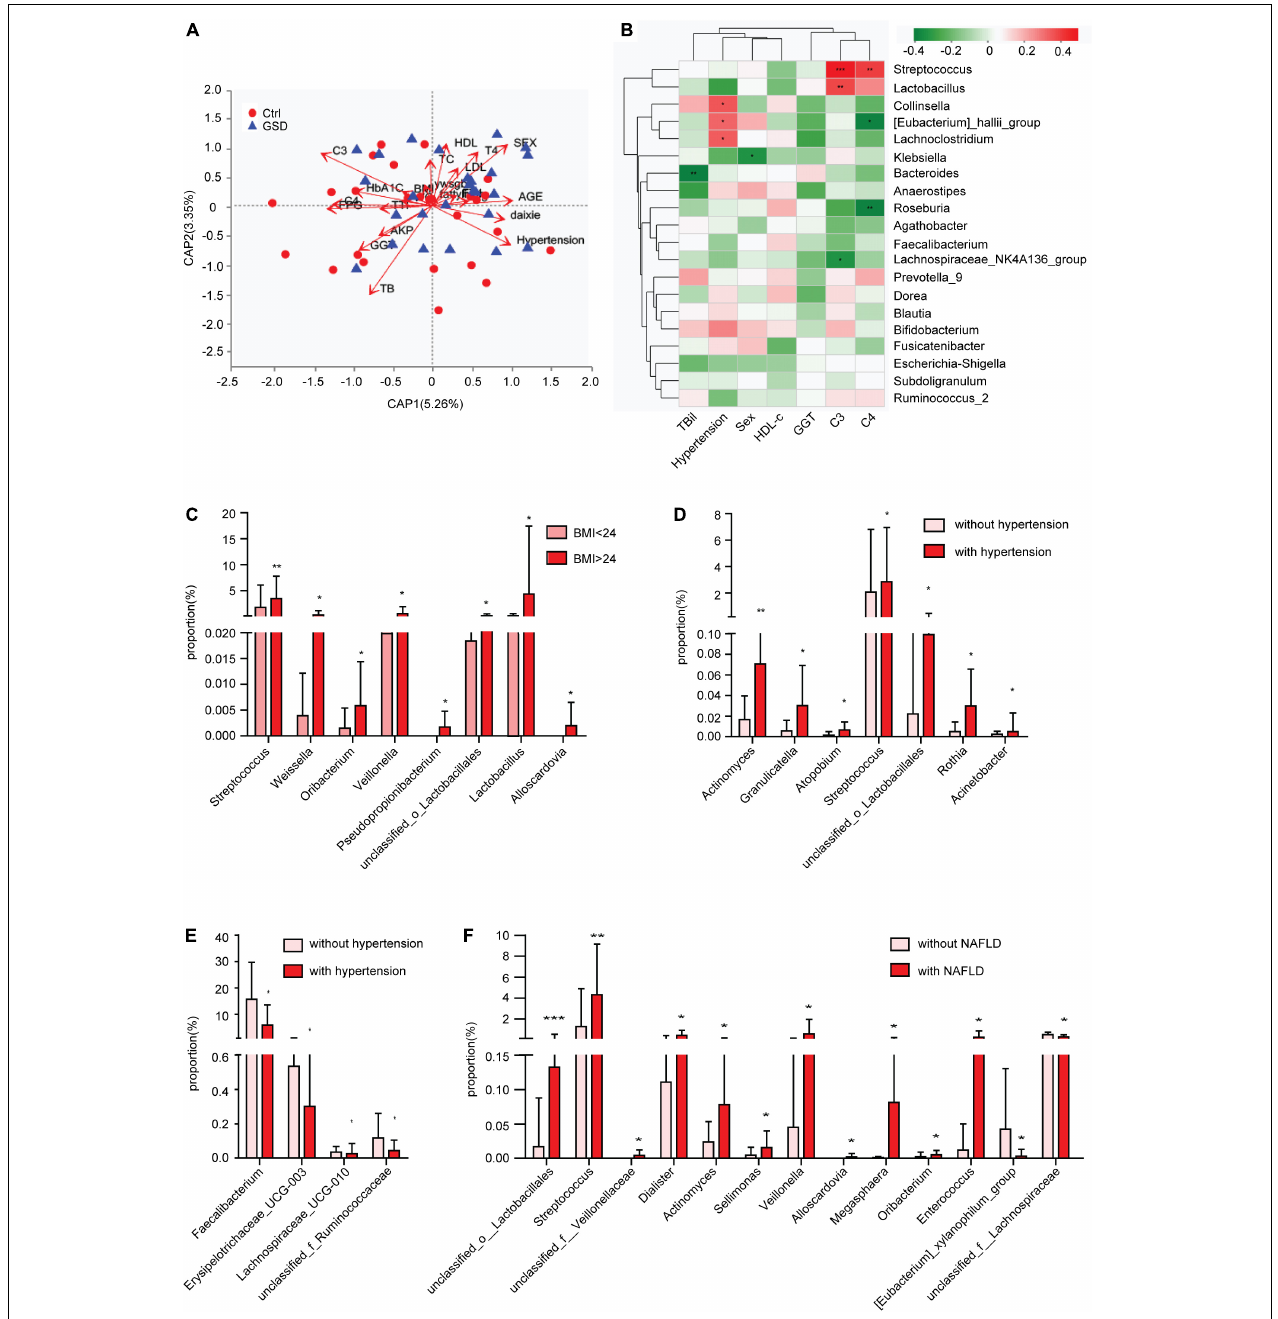
FIGURE 4 | Gut microbial dysbiosis in asymptomatic gallstone patients accompanied with other diseases. (A) Influence index with distance-based redundancy analysis. (B) The relationship between different species (the top 20 abundance, p < 0.1 and VIF < 10) and clinical factors. (C) Differences of gut microbiota composition in asymptomatic gallstone patients with BMI < 24 or BMI (cid:61) 24 (genus level). (D,E) Differences of gut microbiota composition in asymptomatic gallstone patients with or without hypertension (genus level). (F) Differences of gut microbiota composition in asymptomatic gallstone patients with or without NAFLD (genus level). * P < 0.05; ** P <